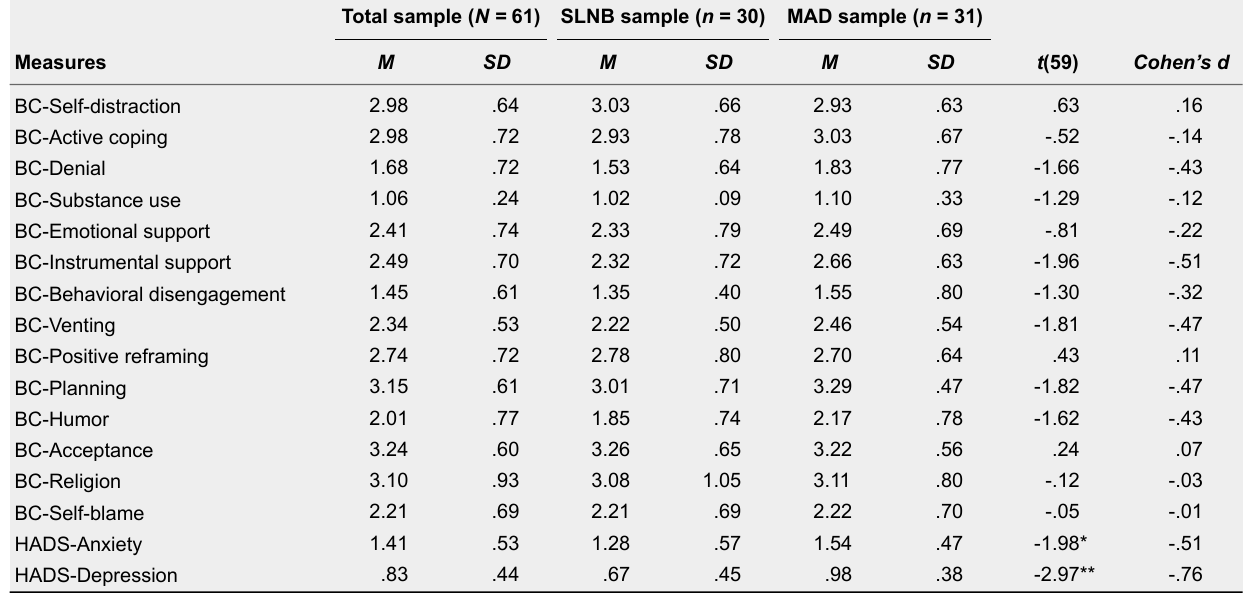
Descriptive Statistics and t-Test for Brief Cope and